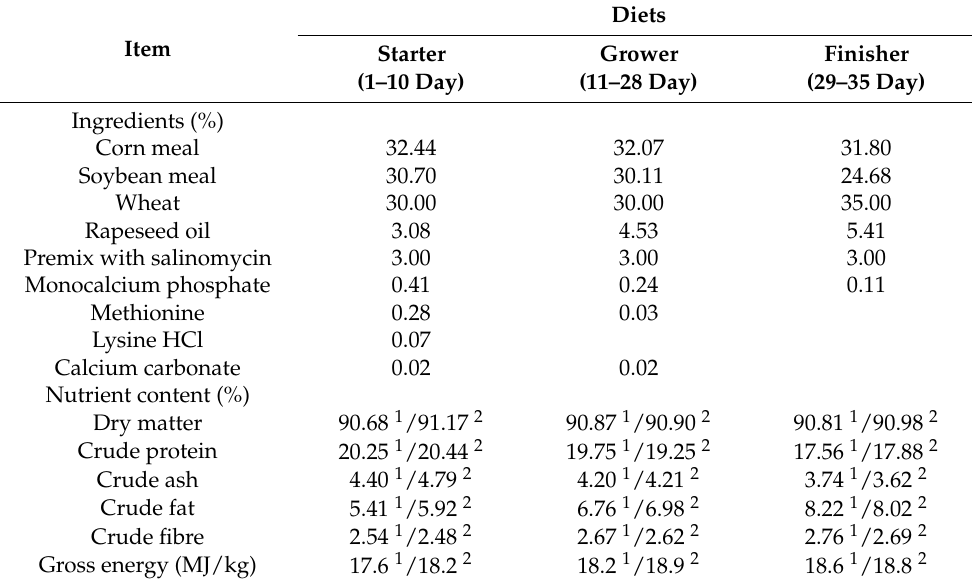
Table 1. Ingredient and chemical composition of the PBC-unsupplemented and PBC-supplemented